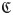
Percentile plot of the distribution of C, S and Φ on T8 under the α-γ-model with α = 0.7 and γ = 0.4.The percentiles of the tree of Fig 8 are also highlighted.